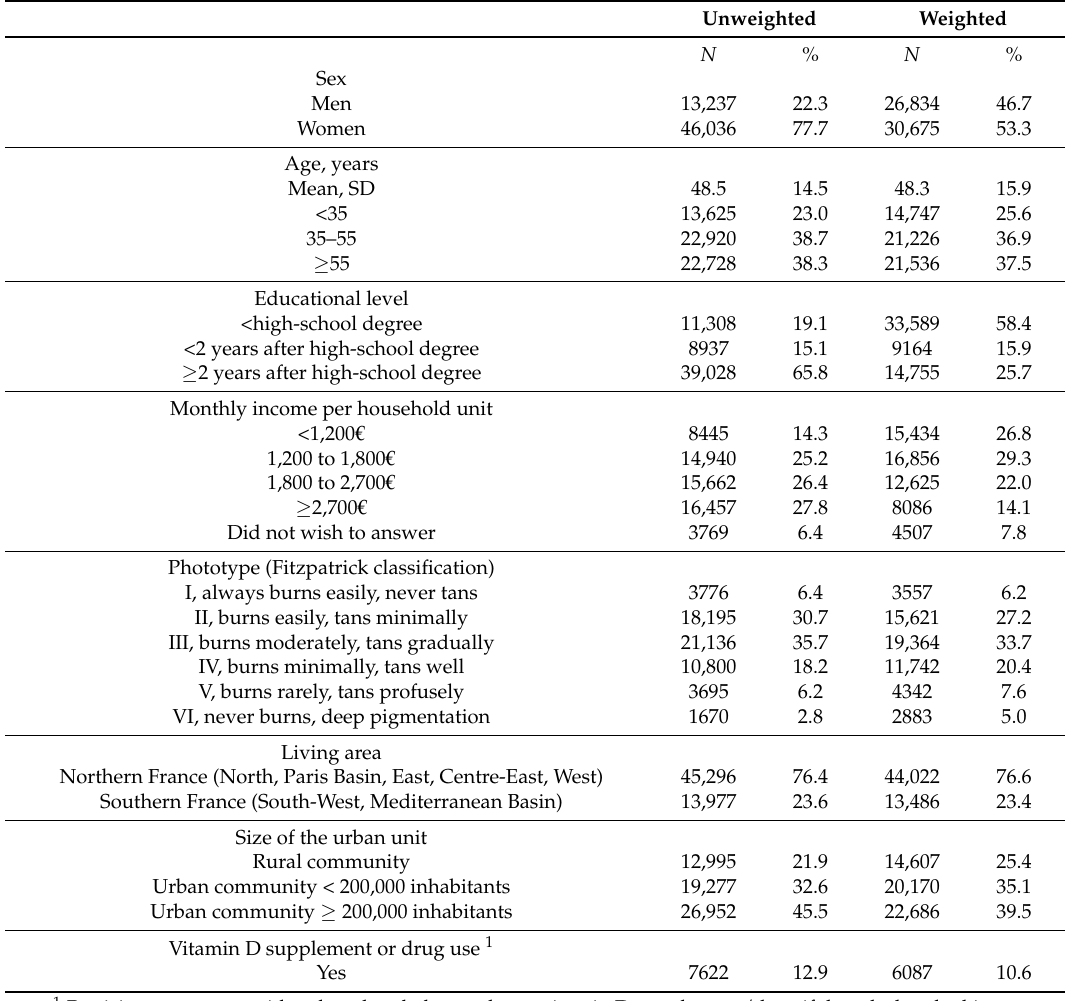
Table 1. Characteristics of the study population before and after statistical weighting, NutriNet-Santé cohort,